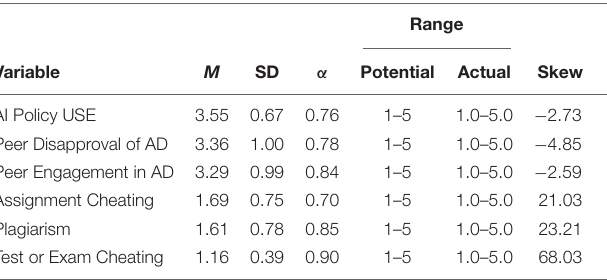
TABLE 4 | Descriptive statistics for the six latent